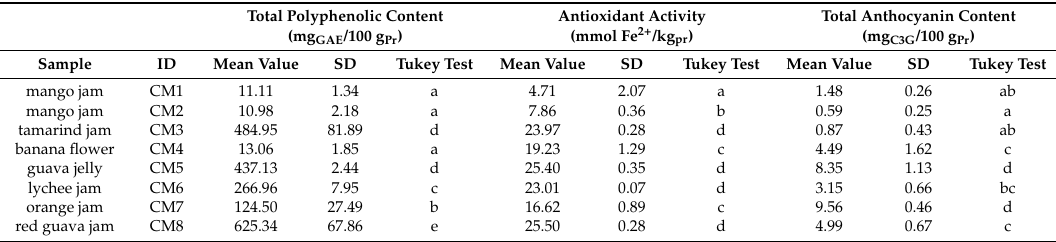
Table 1. Nutraceutical traits of the analysed fruit-derived